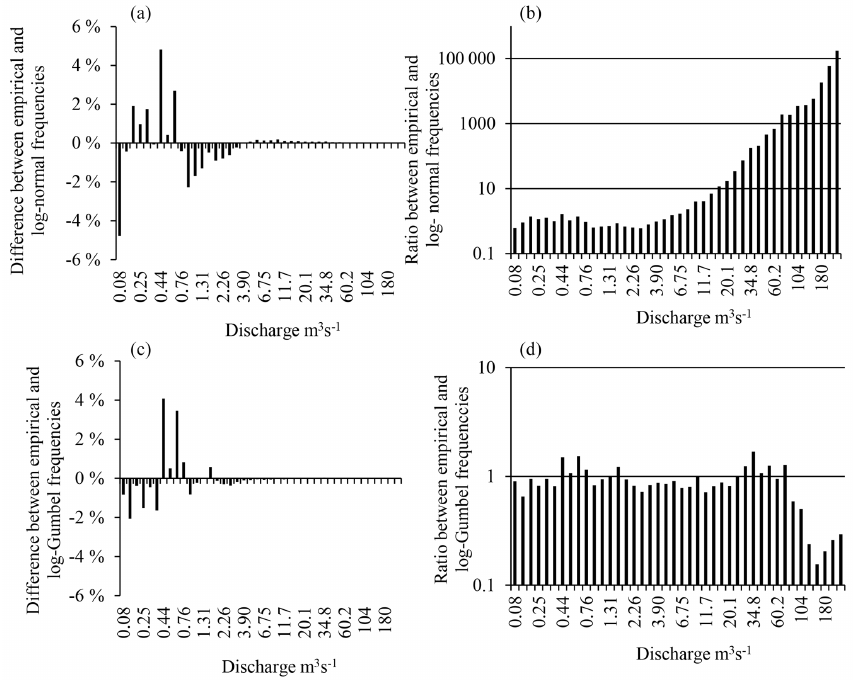
Figure 12. Analysis of errors (difference and ratio) between observed and theoretical frequencies of water discharge: for the log-normal distribution (a, b) and for the log-Gumbel distribution (c, d)